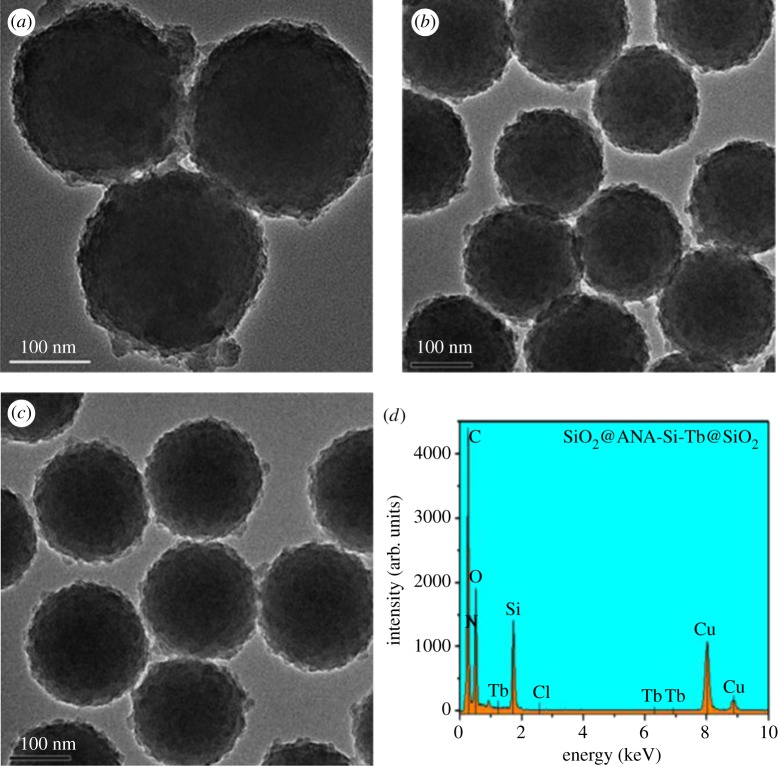
TEM images of SiO2@ANA-Si-Tb@SiO2 (a), SiO2@ANA-Si-Tb-phen@SiO2 (b), SiO2@ANA-Si-Tb-TTA@SiO2 (c) and EDX spectrum of SiO2@ANA-Si-Tb@SiO2 (d).